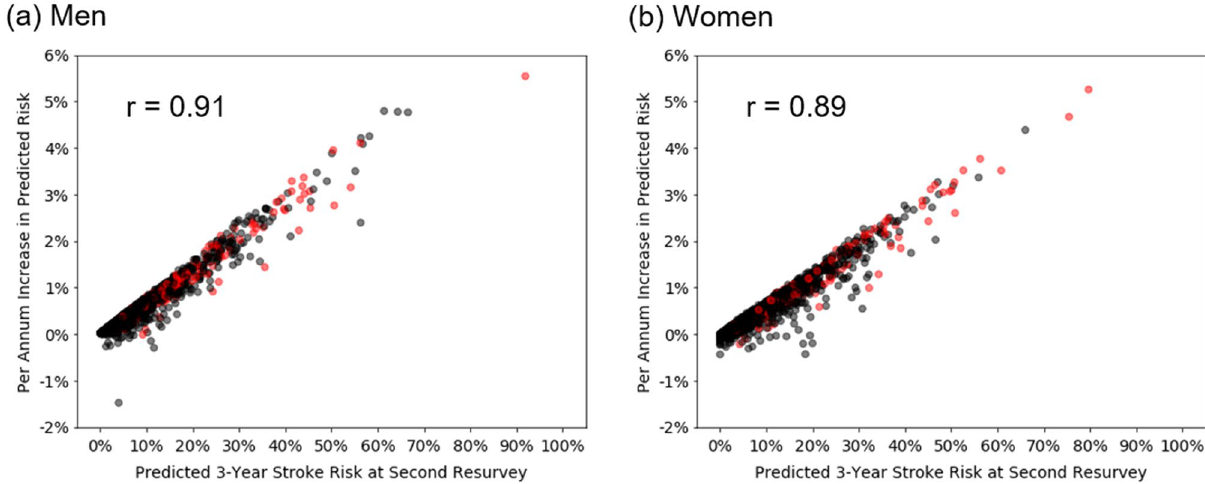
Figure 2. Relationship between predicted 3-year stroke risk at second resurvey and per annum increase in predicted risk (fixed effect slope + random effect slope from linear mixed effects model) for ( a ) men and ( b ) women in the China Kadoorie Biobank. Black points: individuals with no stroke; Red points: individuals with stroke.